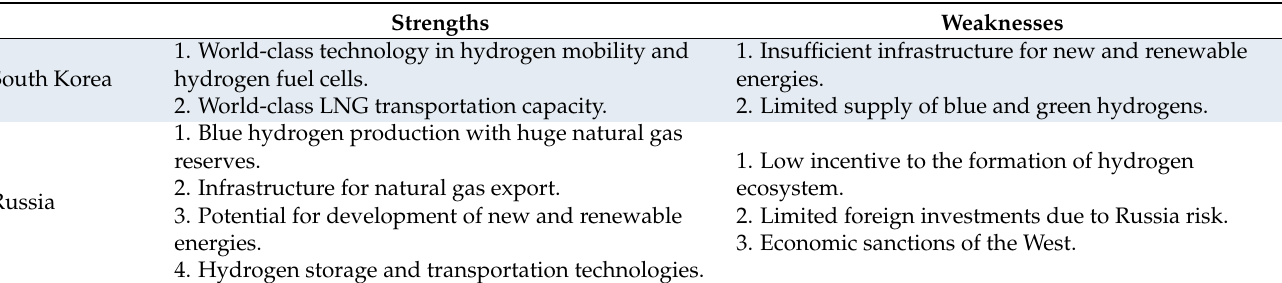
Table 4. Strengths and weaknesses of Korea and Russia’s hydrogen economies.